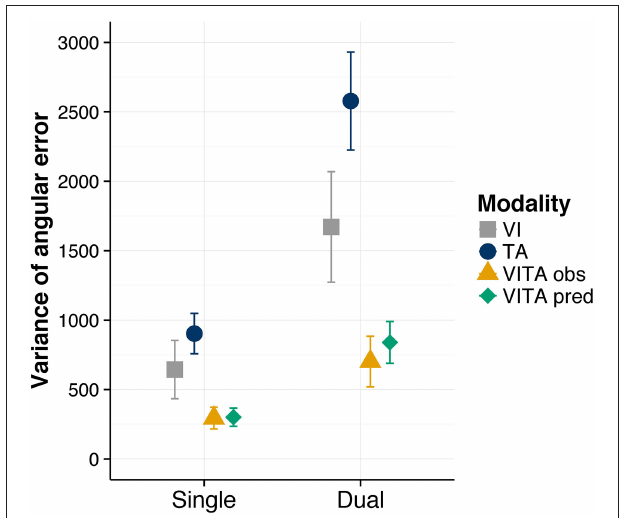
FIGURE 4 | Variance of angular error results. Observed variance of angular error for the visual (“VI”), tactile (“TA”), and visuotactile (“VITA obs”) localization task. “VITA pred” refers to the variance predicted by the MLE model ( Ernst and Banks, 2002 ). Localization task modality is shown separately for the single and dual task conditions. Error bars are standard error of the